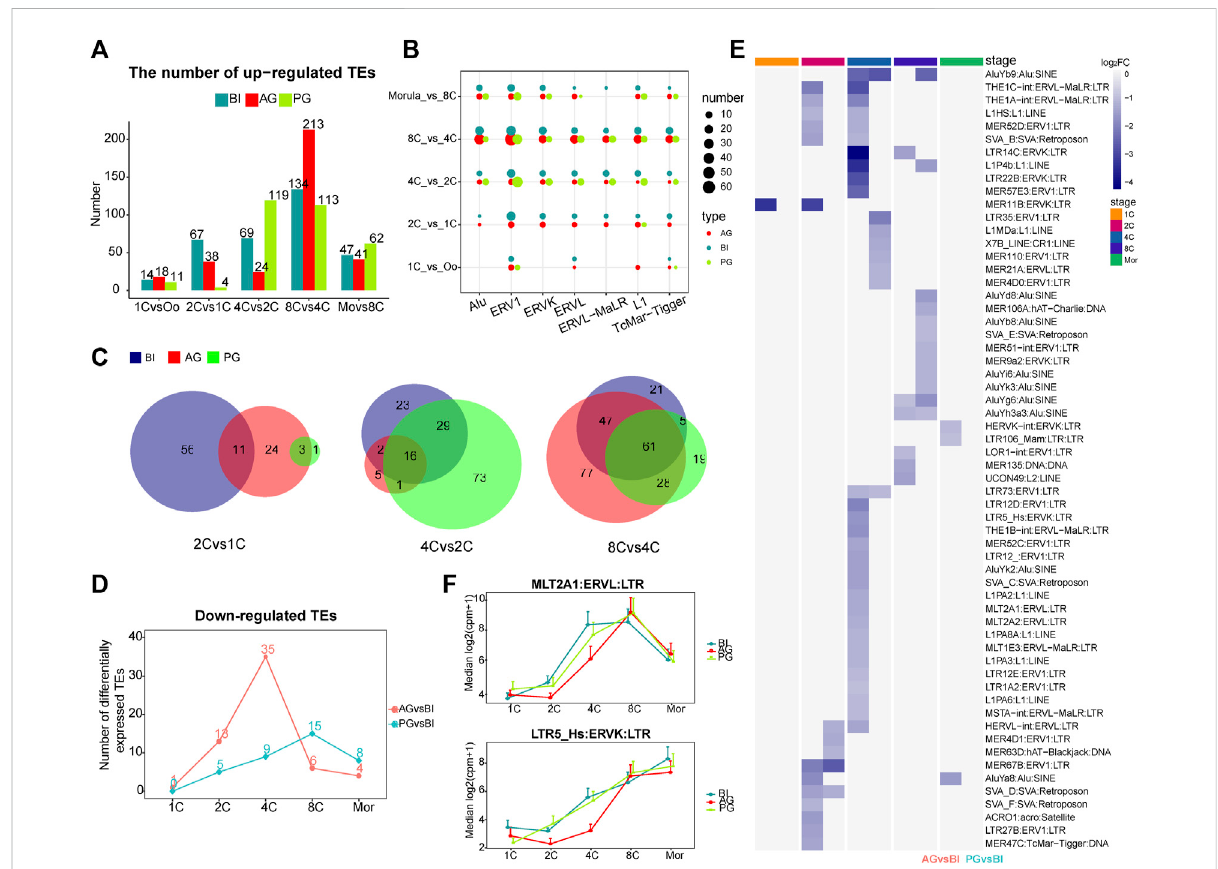
FIGURE 2 Analysis of differential transposon of BI, AG, and PG embryos. (A) Histogram shows the numbers of upregulated differential transposons across consecutive developmental stages. The blue, red and green colors represent BI, AG, and PG embryos, respectively. (B) The number of differential transposons belonging to the seven transposon families during the early development of the three types of embryos. The color of the bubble represents the type of embryo, and the size represents the number. (C) The venn diagram shows the number of common elements of differential transposons during early embryonic development of three types of embryos. The red, green and blue colors represent BI, AG, and PG differentialtransposons,respectively. (D) Thelinechartshowsthenumberofsigni fi cantlydifferentdownregulatedtransposonsbetweenuniparental embryos and biparental embryos at each stage ( p . adj & 0.05 and |log2 (fold-change)| S 1). (E) Heat map shows all the signi fi cantly different transposons in (D) . Color represents the value of log2 (fold-change). (F) The expression levels of MLT2A1 and LTR5_Hs transposon in each developmental stage of three types of